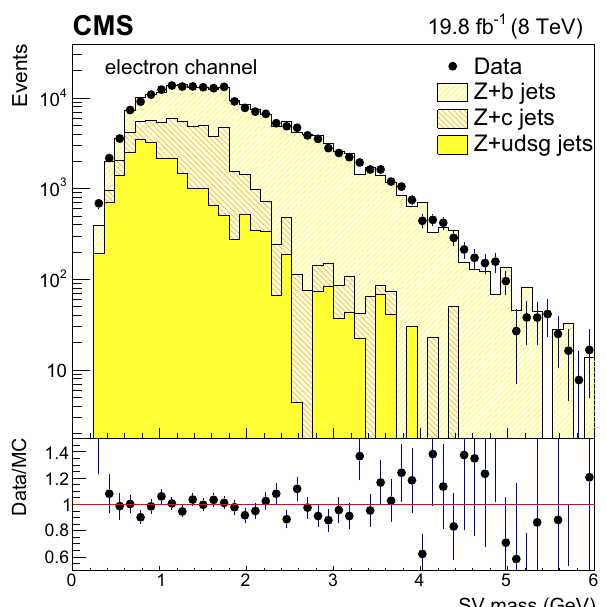
normalizationsdeterminedinthefittodata.Non-Drell–Yanbackground sources are subtracted. Error bars account for statistical uncertainties in data in the upper plots and in both data and simulation in the bottom ratio plots